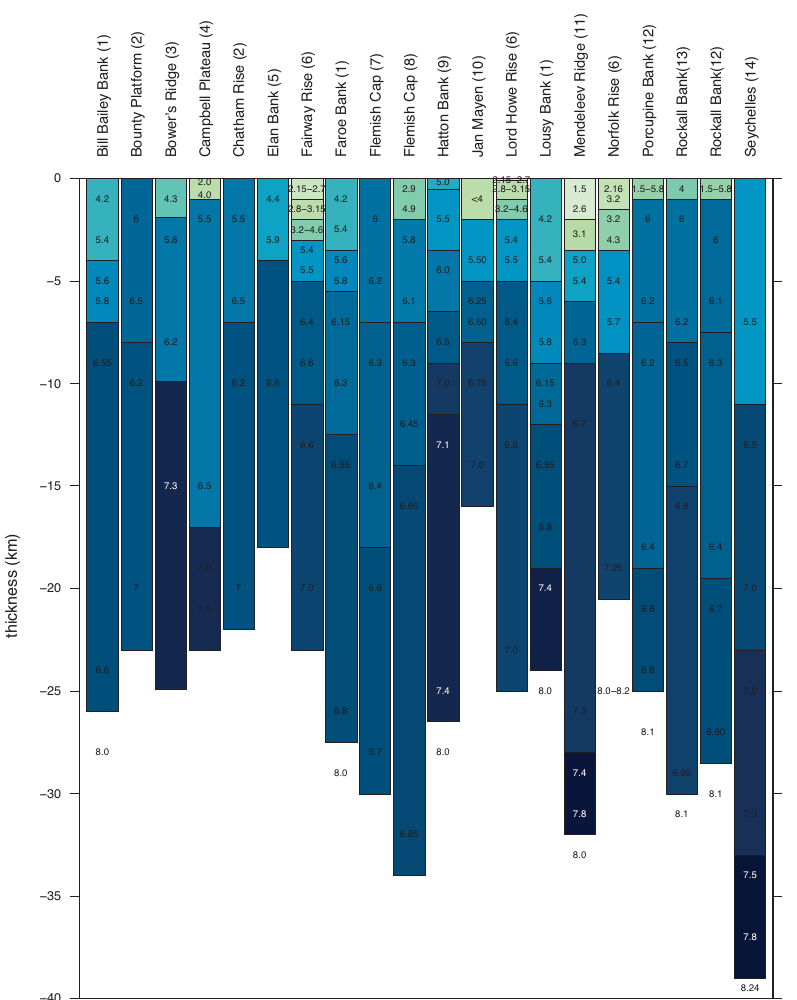
Figure 8. Seismic velocity profiles of modern continental fragments. References are (1) Funck et al. (2008), (2) Grobys et al. (2007), (3) Cooper et al. (1981), (4) Grobys et al. (2009), (5) Borissova et al. (2003), (6) Klingelhoefer et al. (2007), (7) Funck (2003), (8) Gerlings et al. (2011), (9) Fowler et al. (1989), (10) Breivik et al. (2012), (11) Lebedeva-Ivanova et al. (2006), (12) Morewood et al. (2005), (13) Vogt et al. (1998), and (14) Collier et al.